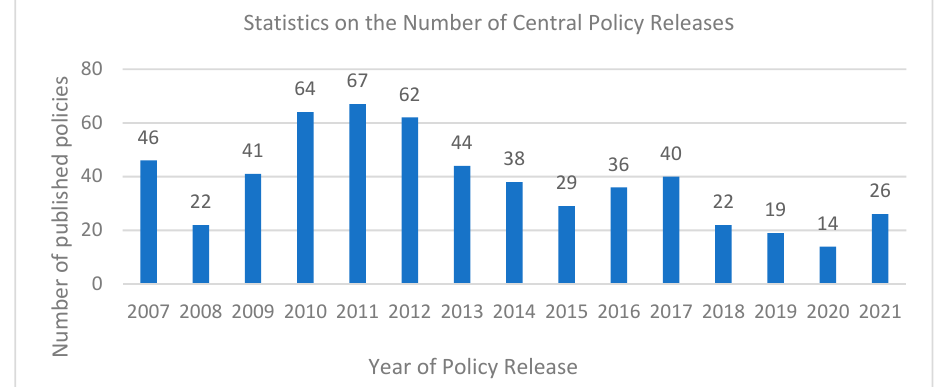
Figure 3. Annual quantitative analysis of the central policy (2007–2021).